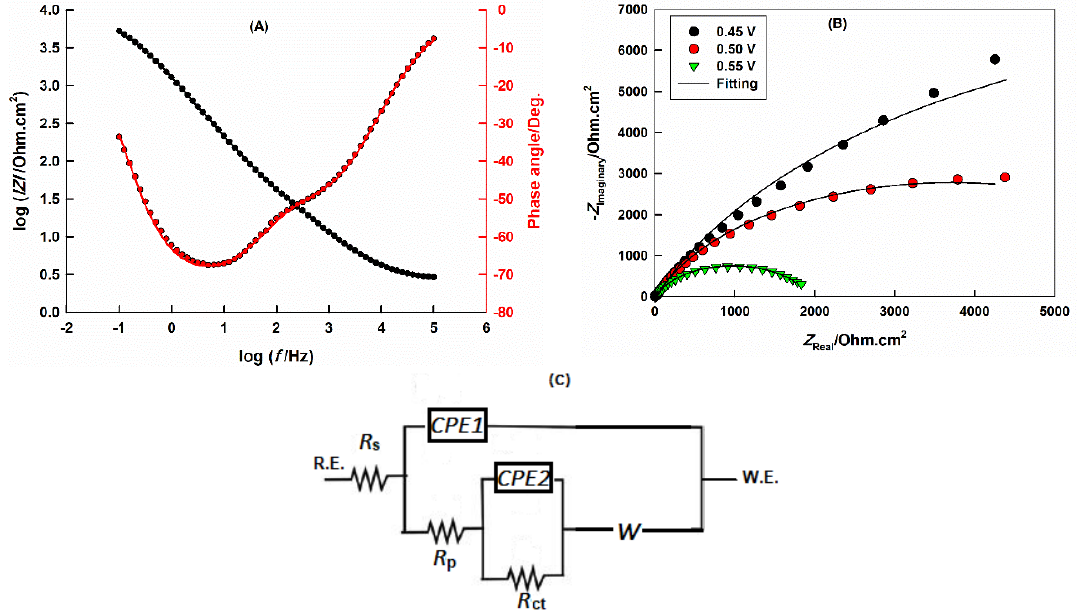
Figure 6. The ( A ) Bode and ( B ) Nyquist plots GC/Sr 2 PdO 3 in 0.1 M HClO 4 at 0.50 V and various overpotentials, respectively. Symbols are experimental and solid lines are modeled data. ( C ) is the electrical equivalent circuit used for fitting.